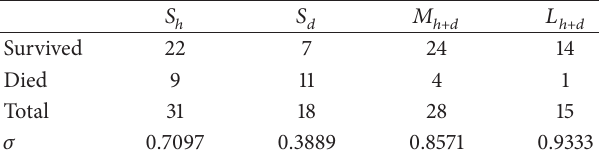
Table 1: Annual survivorship estimates ( 𝜎 ) of healthy ( ℎ ) and dis- eased ( 𝑑 ), small ( 𝑆 ), medium ( 𝑀 ), and large ( 𝐿 ) colonies of Gorgonia ventalina . Fate frequencies obtained from Toledo-Hern´andez et al. (2009) [7].